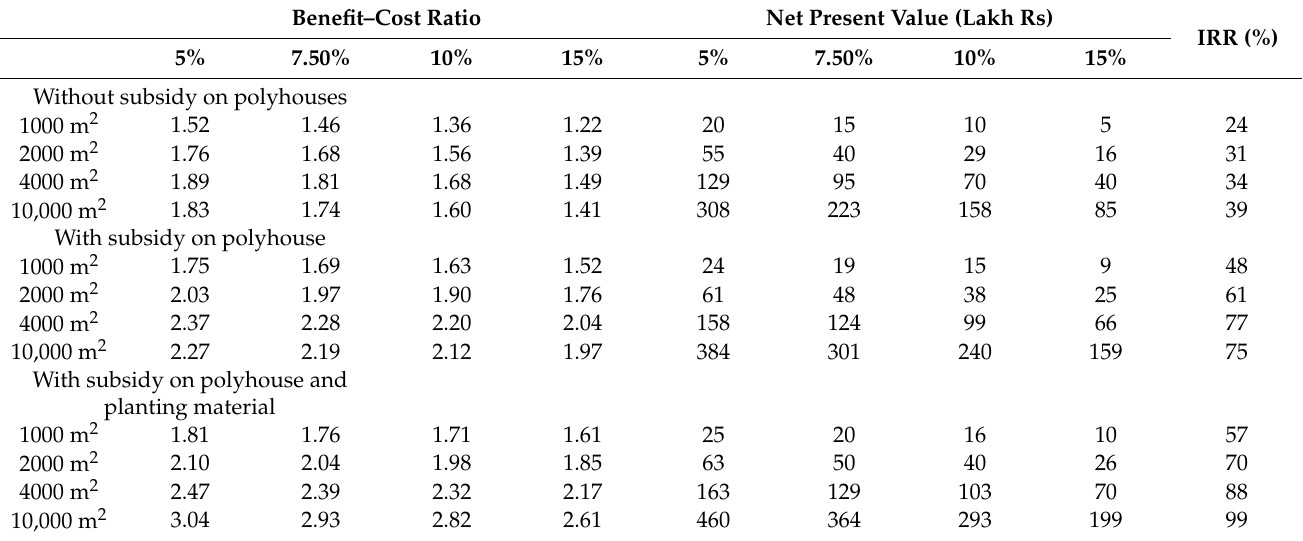
Table 15. Feasibility of polyhouse cultivation of Gerbera in Dehradun district of Uttarakhand, India. Benefit–Cost